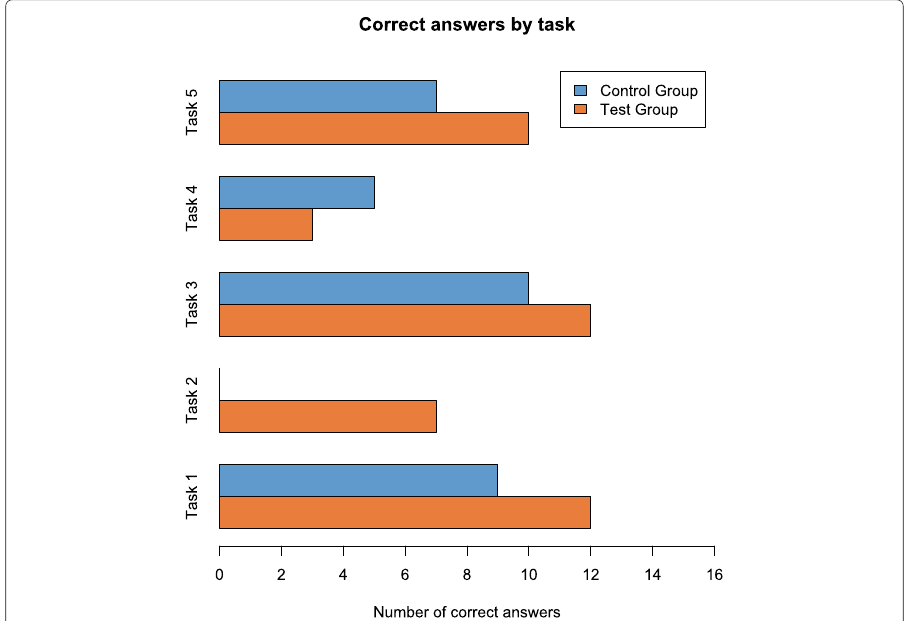
Fig. 12 Number of correct answers by task. Apart from task 4, the test group was outperforming the control group. In case of task 2, it was significantly doing so ( p < 0.01